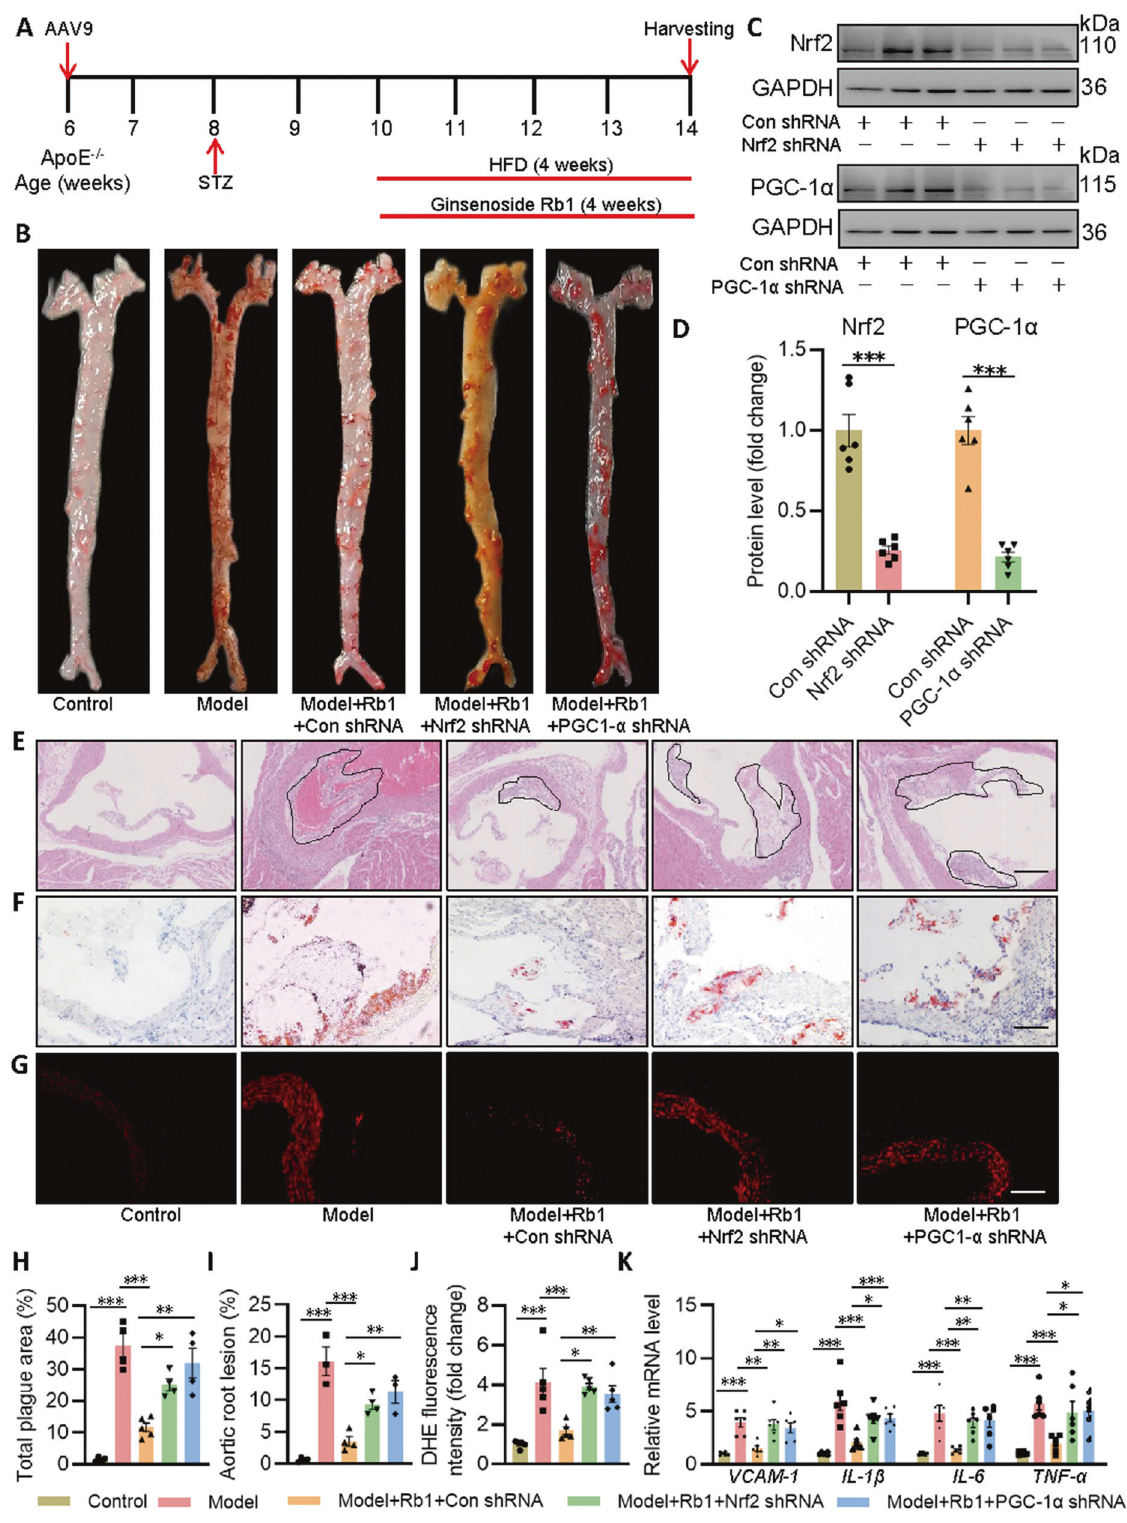
Fig. 8 Nrf2 and PGC-1 α are required for Rb1 to ameliorate diabetes-accelerated atherosclerosis in mice. A Schema showing the experimental procedure in mice. B , H Lesion areas indicated by Oil O Red staining of the thoracoabdominal aorta. C , D Representative blots and quantitative analysis of Nrf2 and PGC-1 α in primary mouse ECs. E , I H&E staining and quanti fi cation of aortic root sections. Scale bar = 100 μ m. F Oil O Red staining of aortic root sections. Scale bar = 100 μ m. G , J DHE staining of thoracic aorta. Scale bar = 50 μ m. K Relative mRNA levels of VCAM-1, IL-1 β , IL-6 , and TNF- α . Data are presented as mean ± SEM. n = 4 – 6. Statistical analysis was performed with the randomized block ANOVA. * P < 0.05; ** P < 0.01; *** P < 0.001; vs . indicated group.